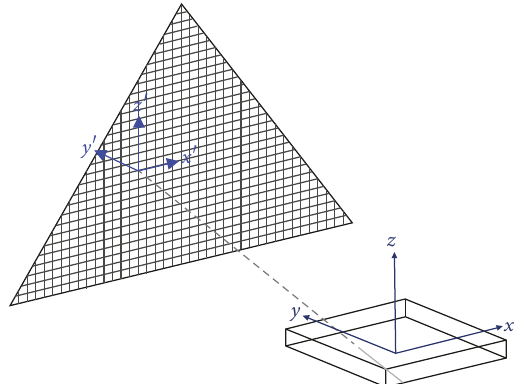
Figure 6: Schematic of the geometry and coordinate system used to simplify the problem. The Pico de Orizaba volcano is represented as a triangular surface located at 5.7 km from the center of the HAWC array. The HAWC detection volume is modelled as a rectangular prism. An example of a vector is shown with a dashed line that becomes solid as the vector passes through the detection volume. The figure is not drawn to scale.